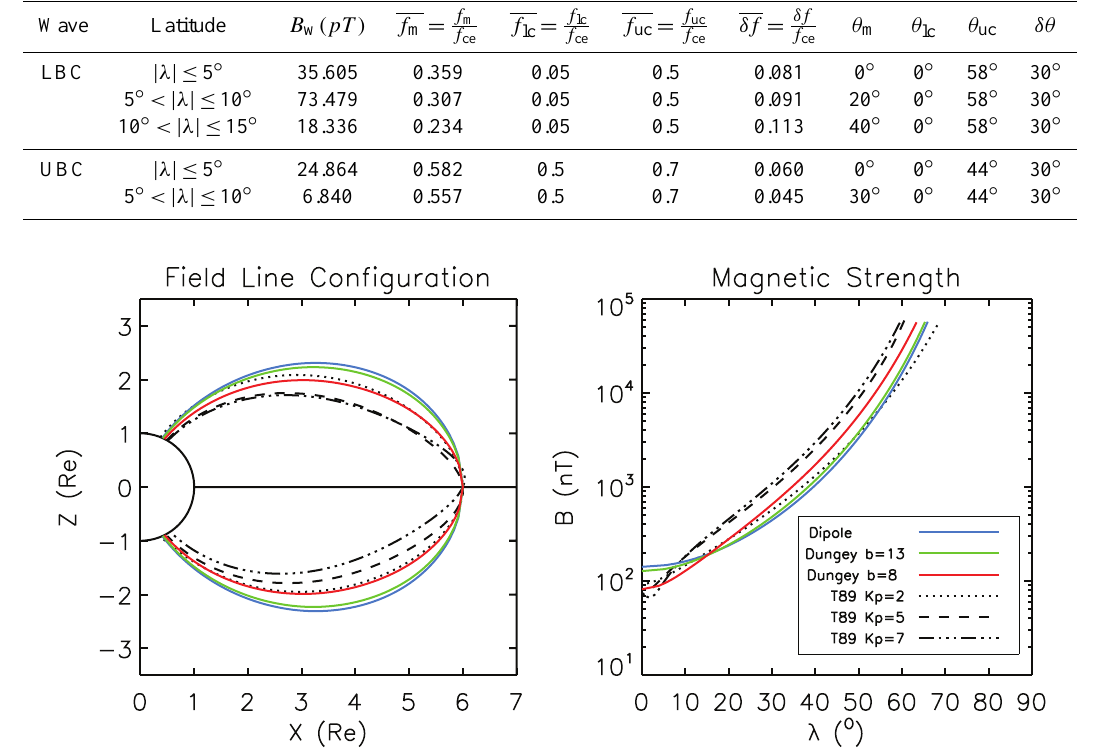
Fig. 1. Comparison of field line configuration (left) and magnetic strength (right) for different magnetic field models at L = 6. Solid curves are the results from the Dungey magnetic field model when b is 8 (red), 13 (green) and infinity (blue); black dotted, dashed, and dash-dotted curves are results from T89 model when Kp is 2 (quiet), 5 (moderate), and 7 (active),